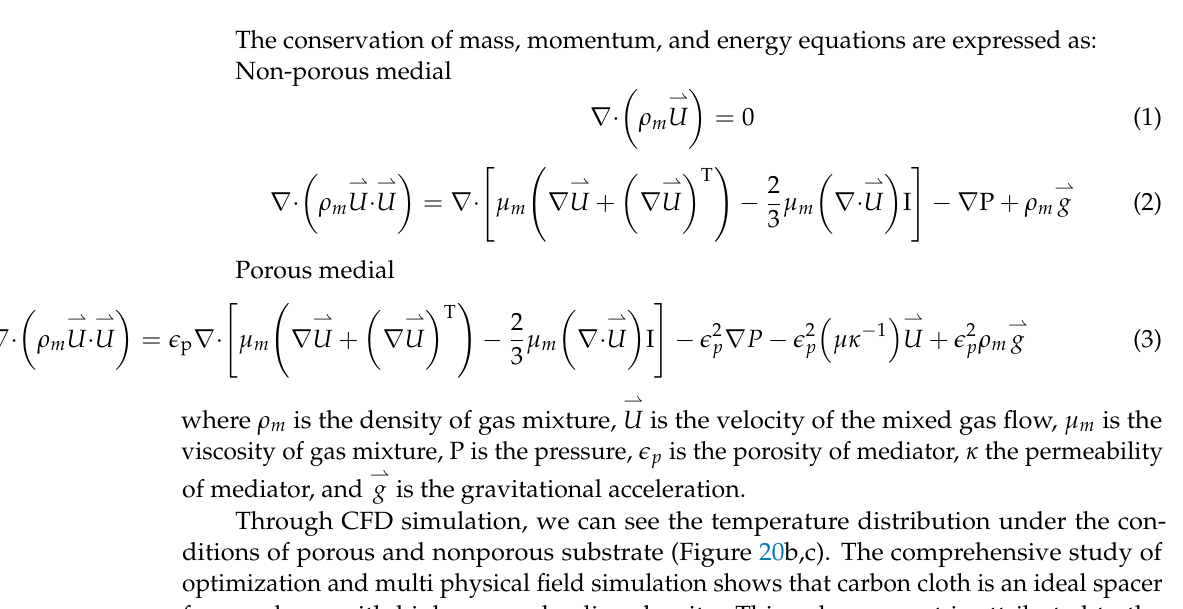
Figure 20. ( a ) Schematic diagram of CVD system simulation. Temperature distribution for the case of ( b ) nonporous and ( c ) 50% porous mediators [172]. Copyright © 2021 Elsevier B.V. and Taiwan Institute of Chemical Engineers. Contours of ( d ) temperature and ( e ) velocity distribution of Richardson number = 221 (Natural convection); ( f ) temperature and ( g ) velocity distribution of Richardson number = 2 (forced dominant-mixed convection). The furnace (red box) temperature is 1000 °C (1273 K) [173].